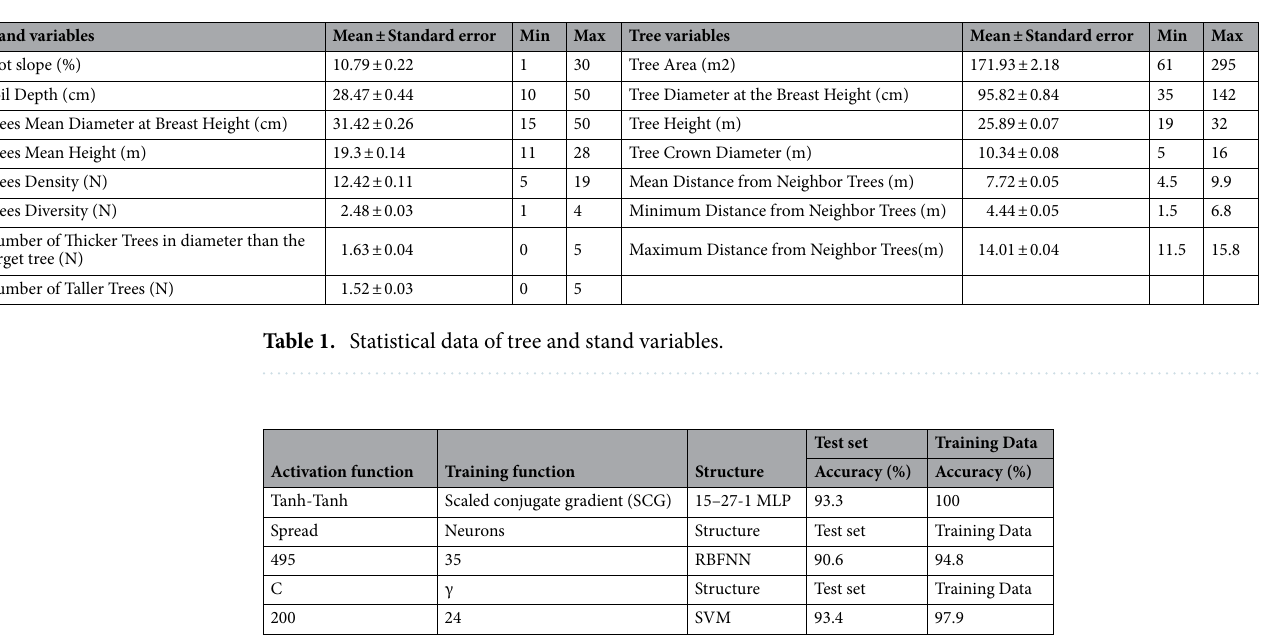
Table 2. The results of parameters tuning in MLP, RBFNN and SVM structure.